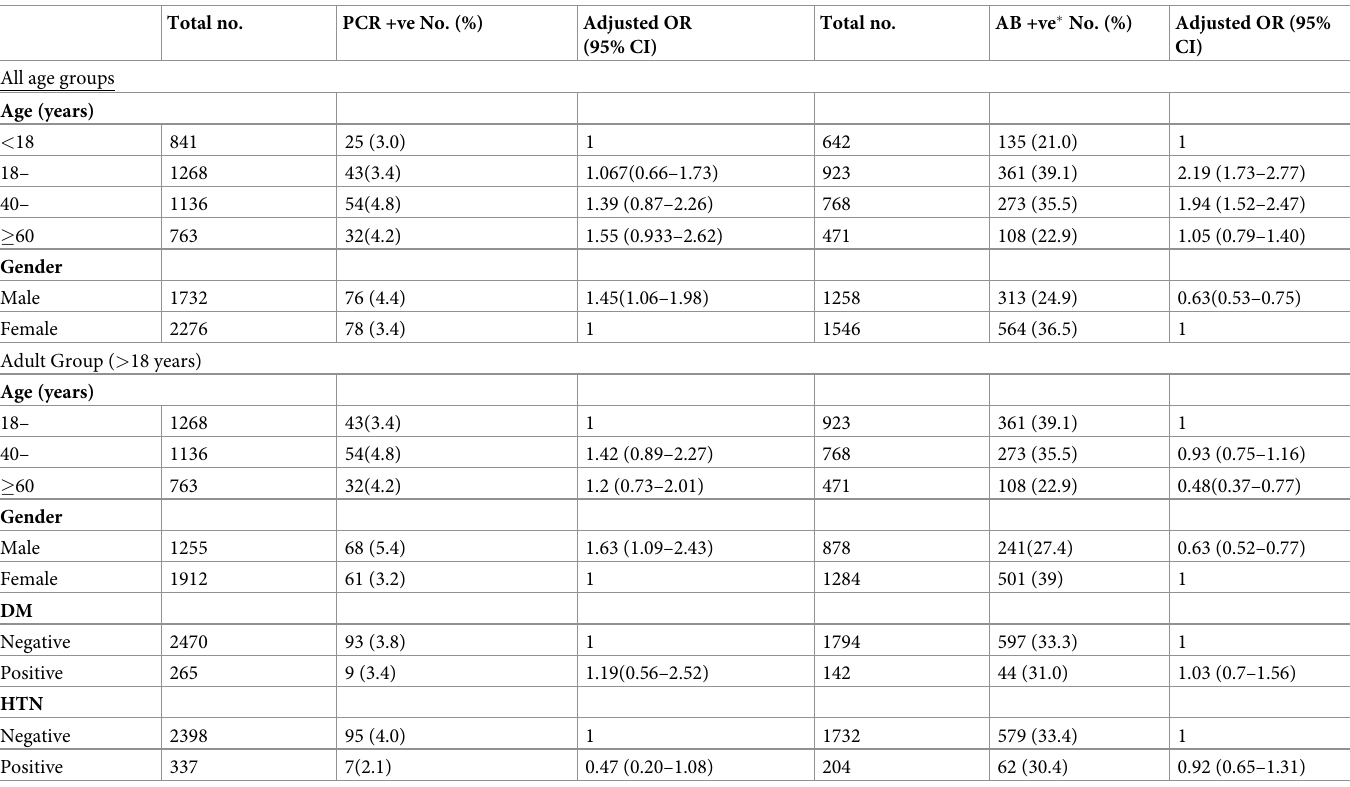
Table 3. Epidemiological profile of SARS-C-V-2 PCR positive and antibody seropositive subjects. Total